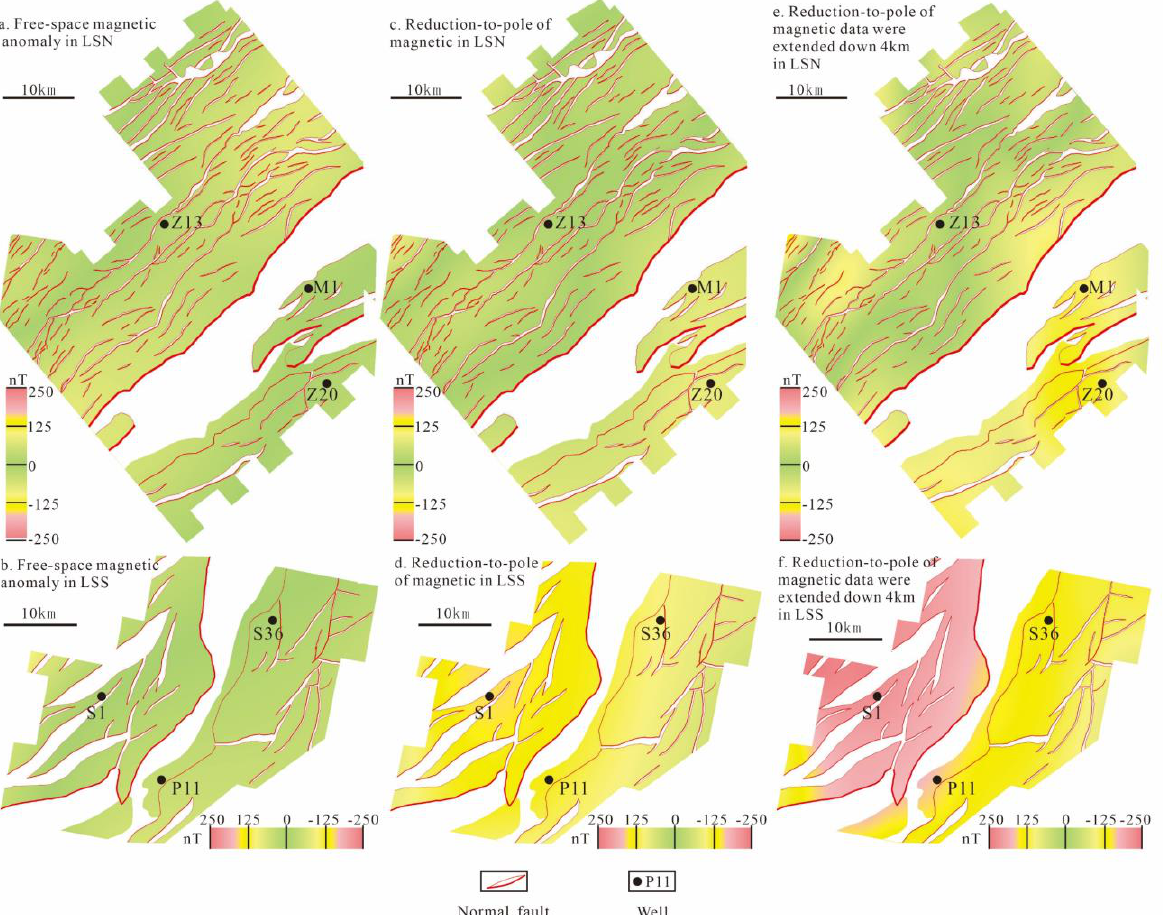
Figure 9. Magnetic anomaly characteristics of basement rocks in the LS depression. Note: ( a , b ) show the free space magnetic anomaly distribution of the LSN and LSS work areas respectively; ( c , d ) show the magnetic anomaly distribution of the reduction-to-pole of magnetic in LSN and LSS work areas respectively; ( e , f ) show the magnetic anomaly distribution of the reduction-to-pole magnetic anomaly data extended down 4km in LSN and LSS work areas respectively.